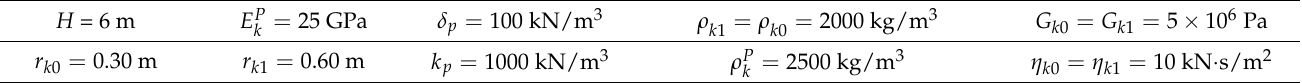
Table 1. The parameters for numerical